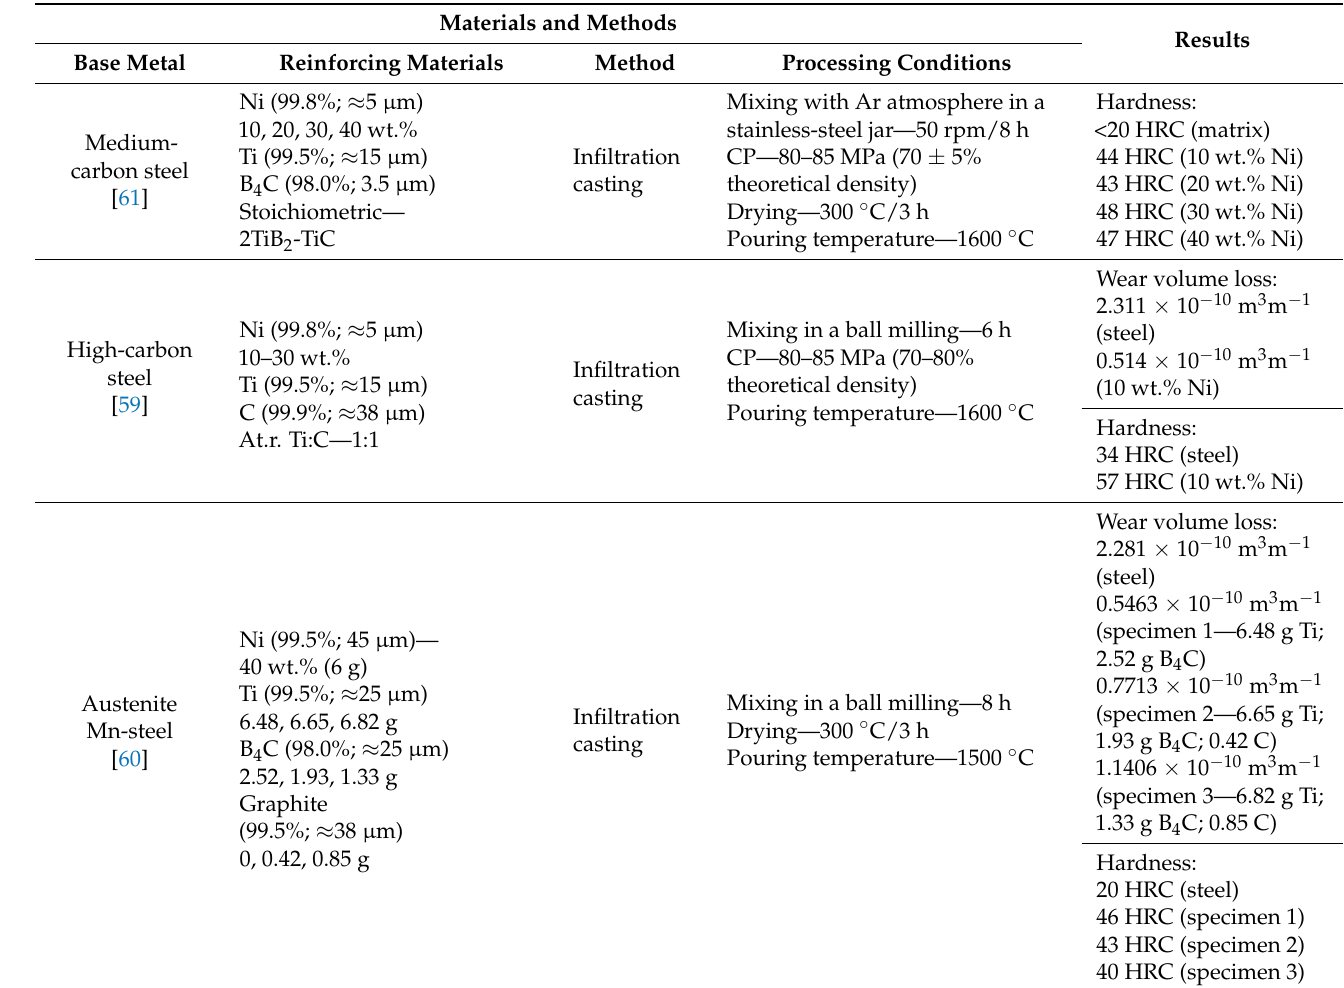
Table 3. Summary of experimental conditions and main results of SHS/casting processing using Ni-Ti-C and Ni-Ti-B 4 C powder